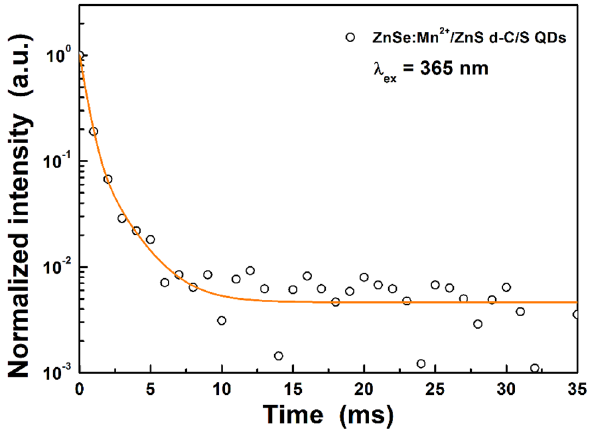
Figure 3. A decay profile of the ZnSe:Mn 2+ (5%)/ZnS d-C/S QDs under 365 nm UV